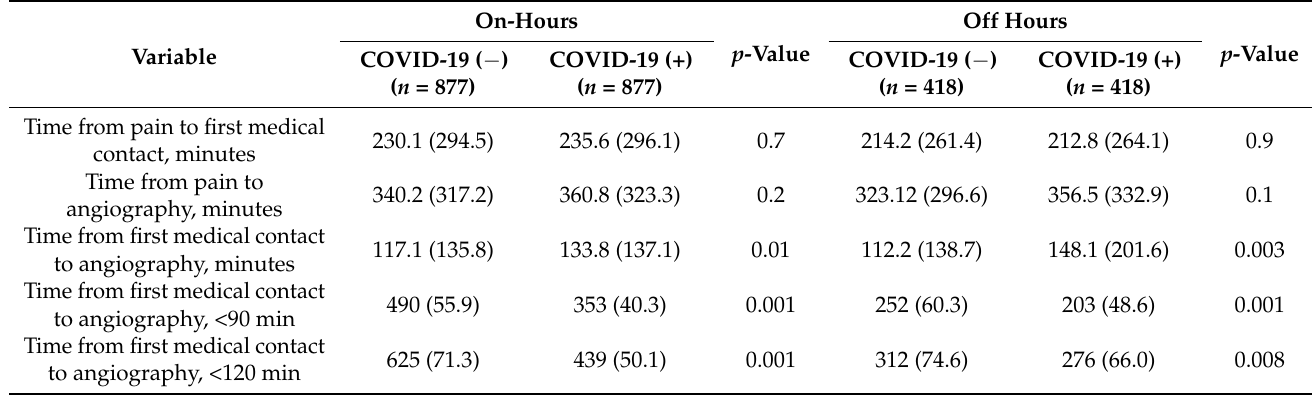
Table 5. Treatment delays after propensity score